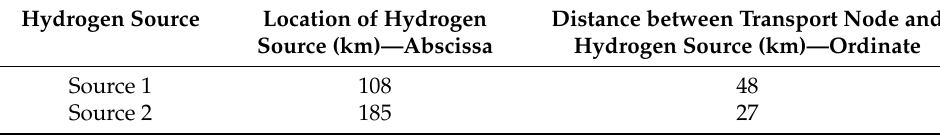
Table 3. Summary of location of hydrogen sources.